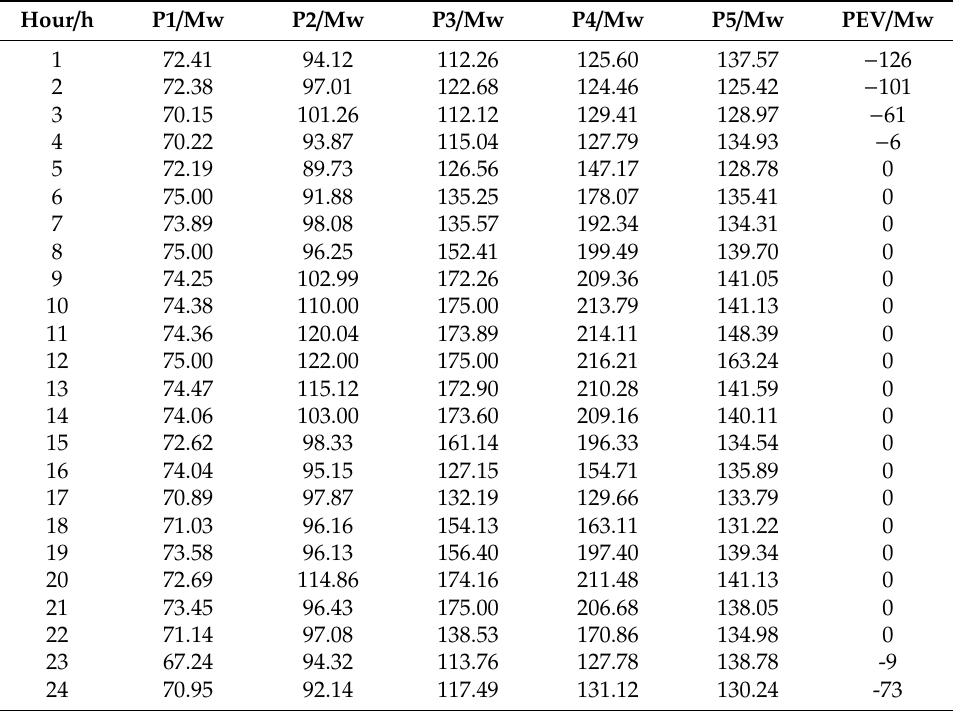
Table 5. 24-h output of per unit under optimal scheduling in Case 2.2.